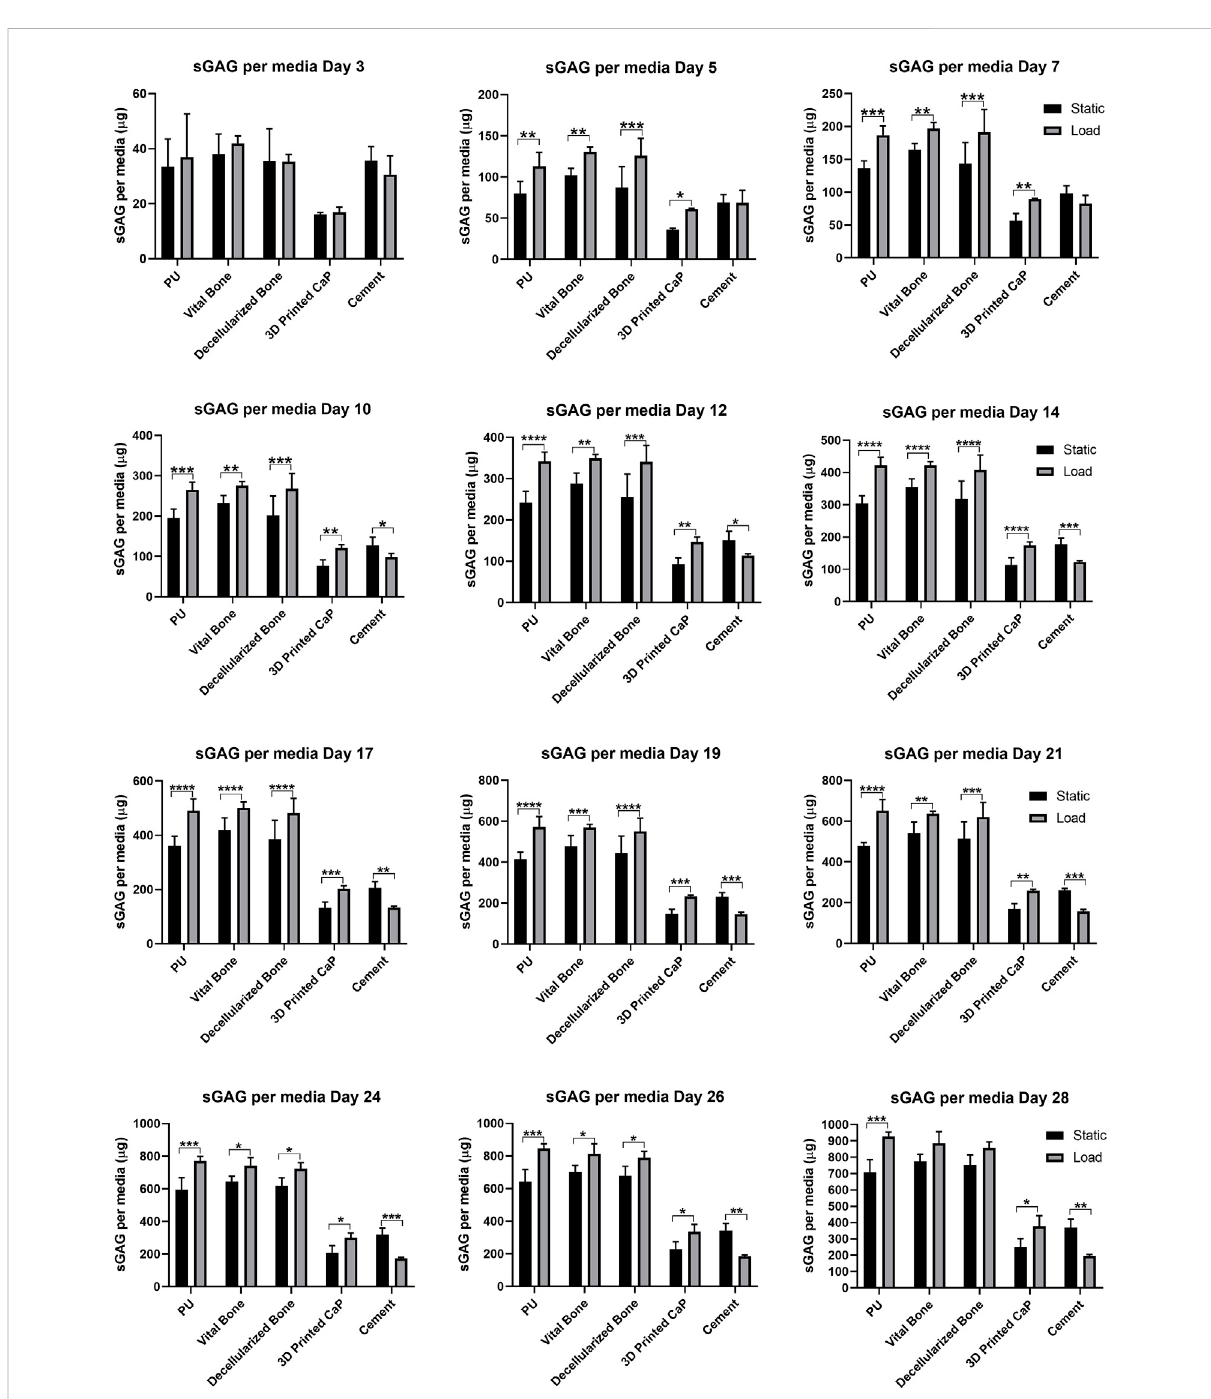
FIGURE 5 sGAG released into media by day. Media was sampled every two days and the sGAG contained within was quanti fi ed. By day 5 signi fi cant load induced differences were observed due to load and these were maintained throughout the experiment. * p < 0.05, ** p < 0.01, *** p < 0.001, **** p <